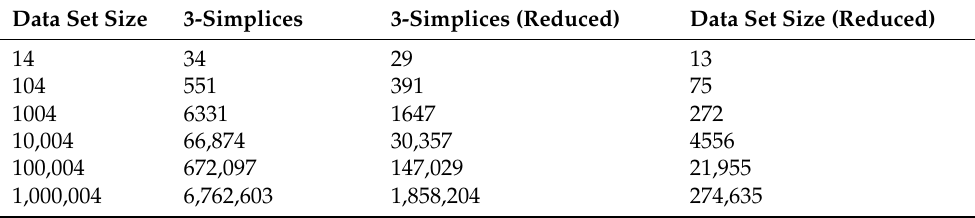
Table 3. The size of the three-dimensional synthetic data sets used, the number of 2-simplices obtained after computing the Delaunay triangulations, and the ones obtained after applying Algorithm 1. Data Set